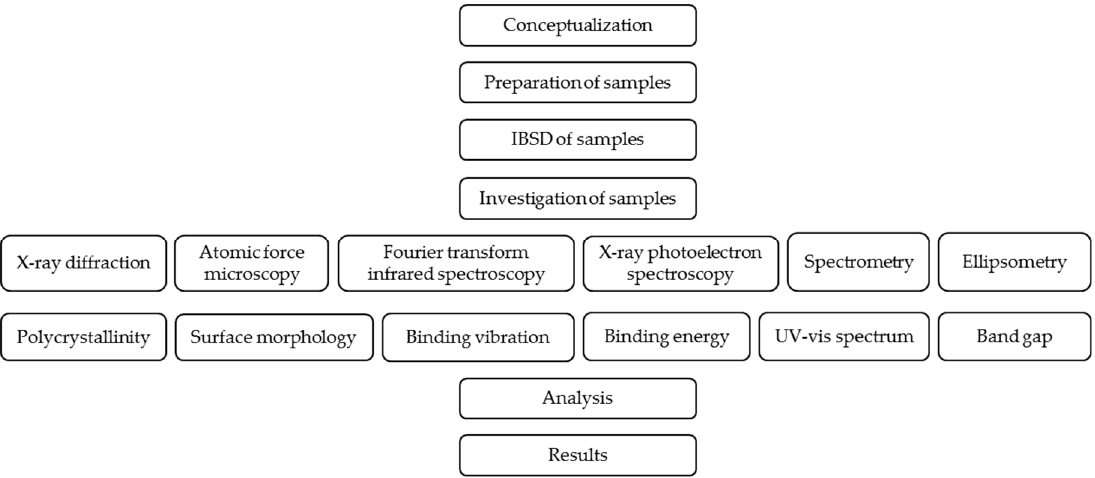
Figure 1. Schematic representation of the experimental procedure.